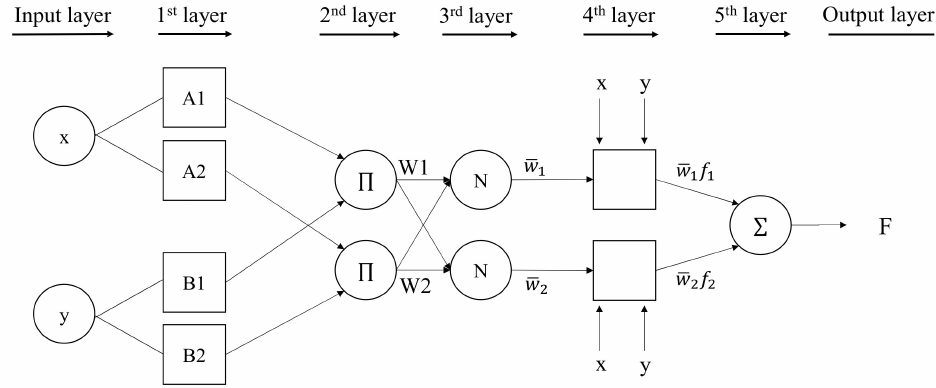
Figure 2. Schematic structure of ANFIS model with two inputs. The idea of the RBF network is based on the solutions of statistical methods of approx- imating the function of a numeric variable. A typical RBNFN is a structure containing: an input layer on which signals described by the input vector x are applied, a hidden layer with radial neurons (weights correspond to cluster center, usually the Gaussian function), and an output layer normally composed of one neuron (linear weighted sum), whose role is the weight summation of signals from hidden neurons [71]. Figure 3 presents the topology of the RBF model as a multi-input–single-output network composition.